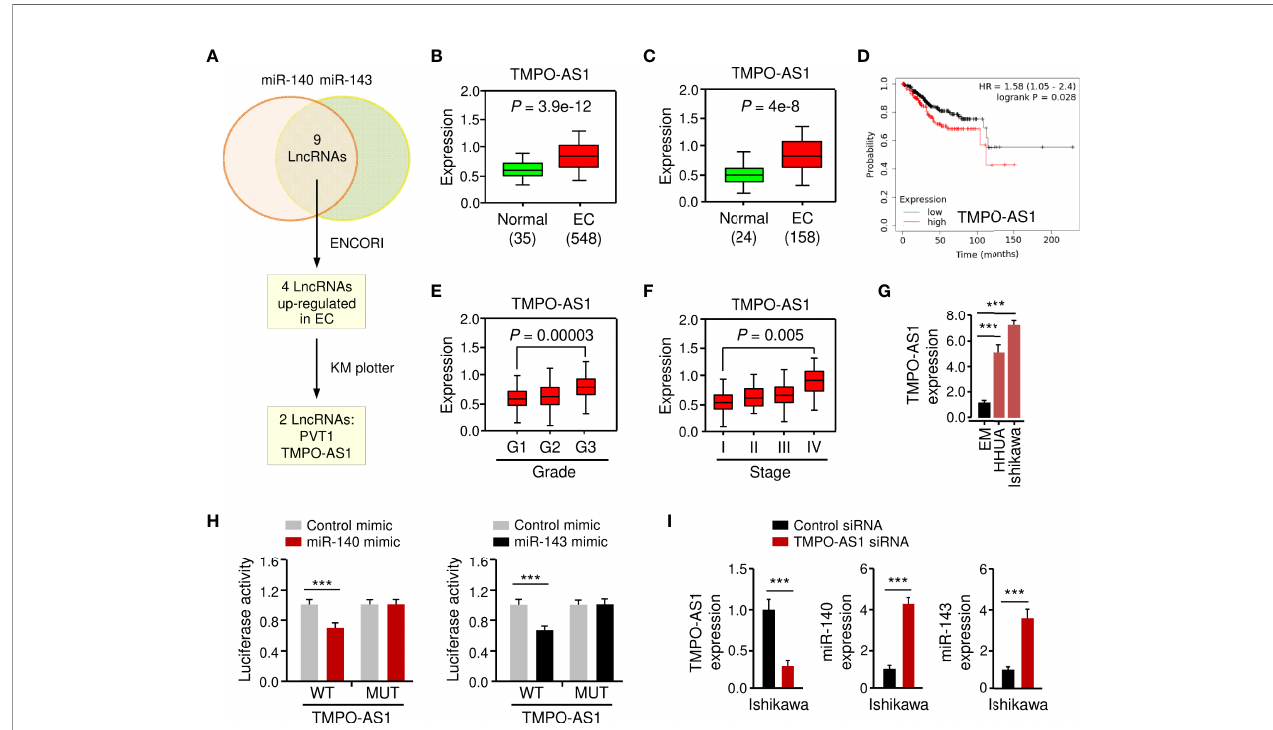
FIGURE 7 | LncRNA TMPO-AS1 Interacts with MiR-140 and MiR-143 to Inhibit Their Expression. (A) Work fl ow for identifying possible lncRNAs that regulate the expression of miR-140 and miR-143 simultaneously. (B, C) Expression of TMPO-AS1 in TCGA EC and normal tissues ( B : ENCORI database; C : Wanderer database). (D) The probability of overall survival in EC patients expressing high or low TMPO-AS1 levels was examined using the KM plotter database. (E, F) TMPO- AS1 expression analysis in EC samples with varying histologic grades ( E : well (G1), moderate (G2), and poor (G3)) and tumor stages ( F : I – IV) (TANRIC database). (G) qRT-PCR analysis of TMPO-AS1 expression in EC and EM cells. (H) Luciferase reporter assays in Ishikawa cells transfected with wild-type (WT) or mutant (MUT) TMPO-AS1 fragments, as well as miR-140/miR-143 mimic or control mimic. (I) The expression of TMPO-AS1, miR-140, and miR-143 in Ishikawa cells